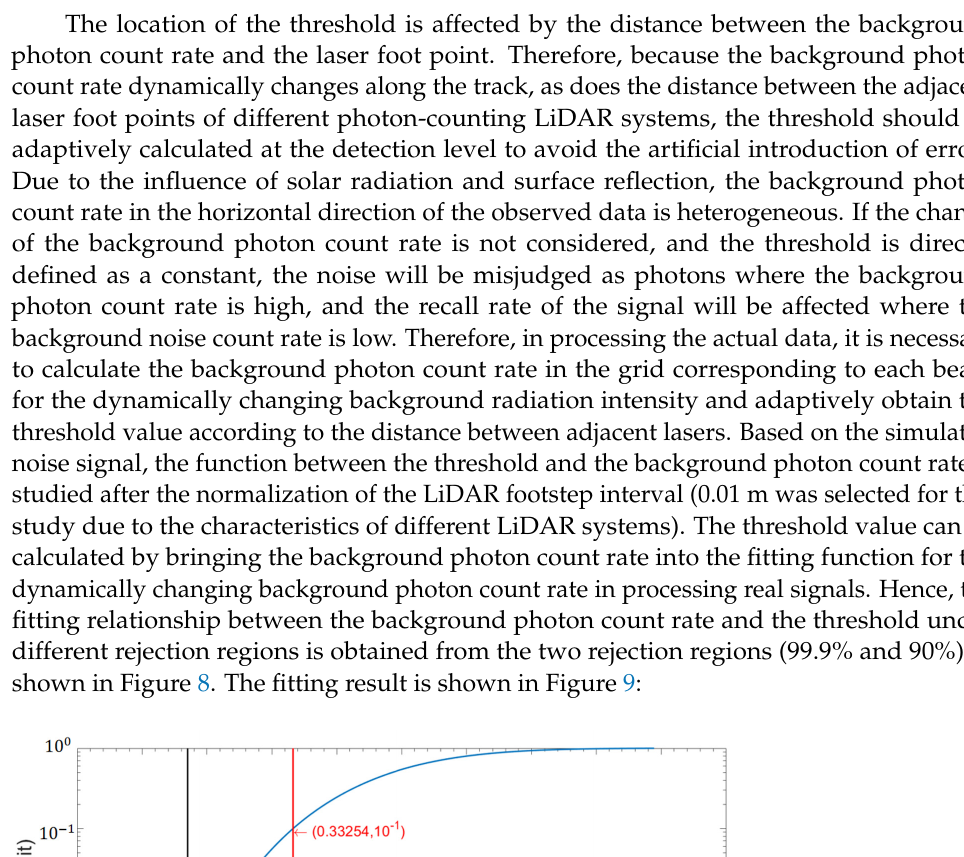
Figure 8. The fitting result is shown in Figure 9: